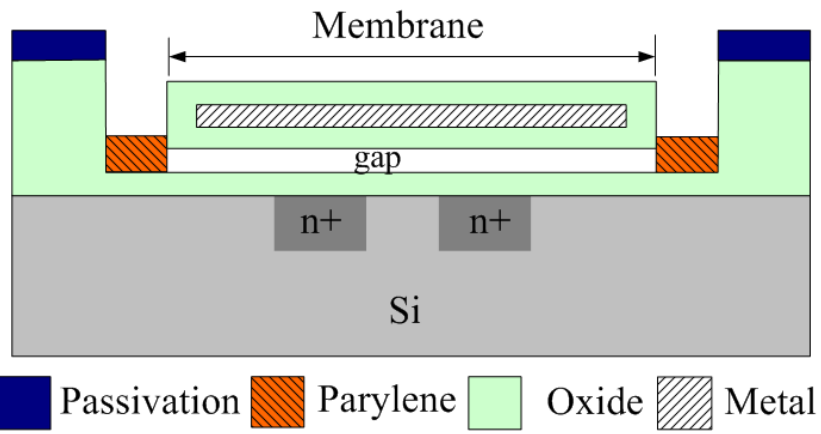
Figure 2. Schematic cross-sectional view of a sensing cell.